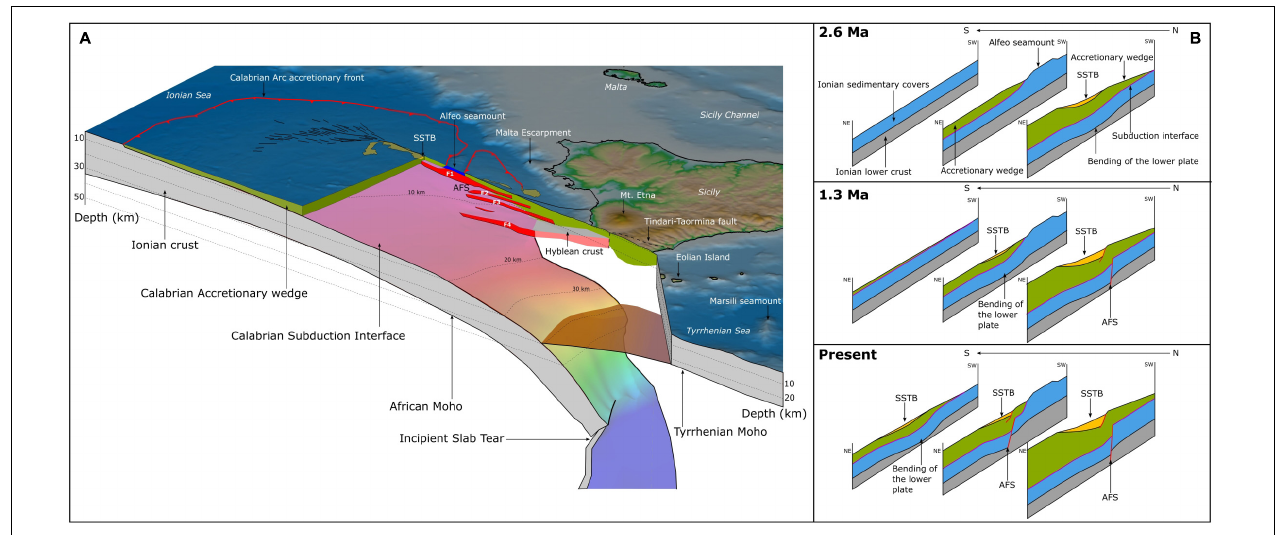
FIGURE 10 | Role and evolution of the Alfeo Fault System (AFS). (A) 3D diagram showing the structural relationships between the different elements at the southwestern lateral termination of the Calabrian north-dipping slab. (B) Space-time schematics of the southward growth and propagation of the Alfeo Fault